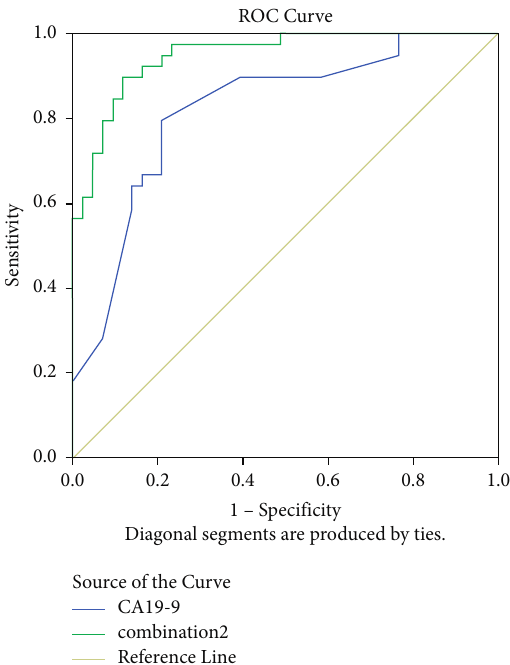
Figure 6: ROC curves of the diagnostic ability of combination2 versus CA19-9.